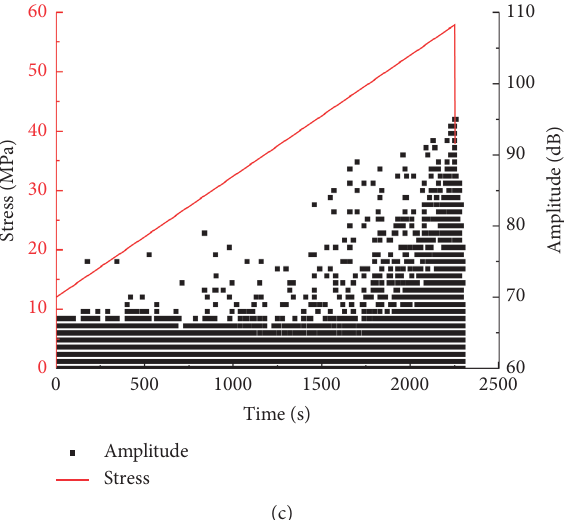
Figure 7: Acoustic emission characteristic map of the conventional gas-bearing coal sample: (a) stress-ringdown count-cumulative count- time; (b) stress-energy-cumulative energy-time; (c) stress-amplitude-time.